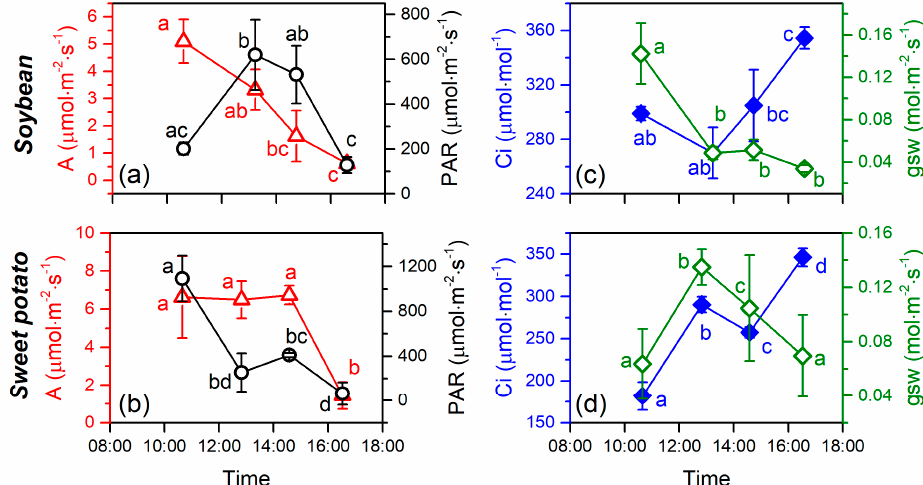
Figure 6. Diurnal patterns of the gas exchange measurements: ( a ) and ( b ) the net photosynthetic rate (A) accompanied by photosynthetically active radiation (PAR), ( c ) and ( d ) intercellular carbon dioxide concentration (Ci) accompanied by stomatal conductance (gsw). The upper panel shows the soybean results, and the lower panel shows the sweet potato results. The PAR in the left column was measured synchronously with the gas exchange measurements using Li-6800. Signi fi cant differences (P < 0.05) between the mean values in the fi gure are marked by different letters above the symbols, while the letters with a same letter showed that the difference is not signi fi cant. For example, as shown in Figure a, the letters “a” and “ab” corresponding to first and second measurement of A represent that their difference is insigni fi cant, while the letters “a” and “bc” corresponding to the first and third one represent that the difference is signi fi cant.